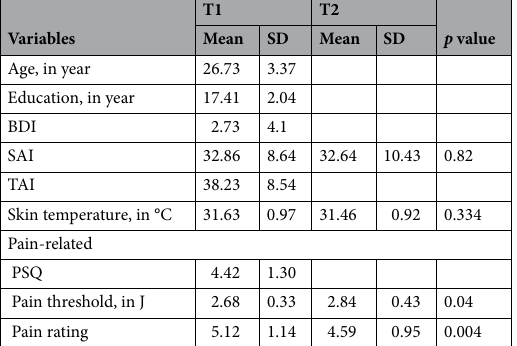
Table 1. Demographics and behavioral results. BDI Beck Depression Inventory, SAI State Anxiety Inventory, TAI Trait Anxiety Inventory, PSQ pain sensitivity questionnaire, SD standard